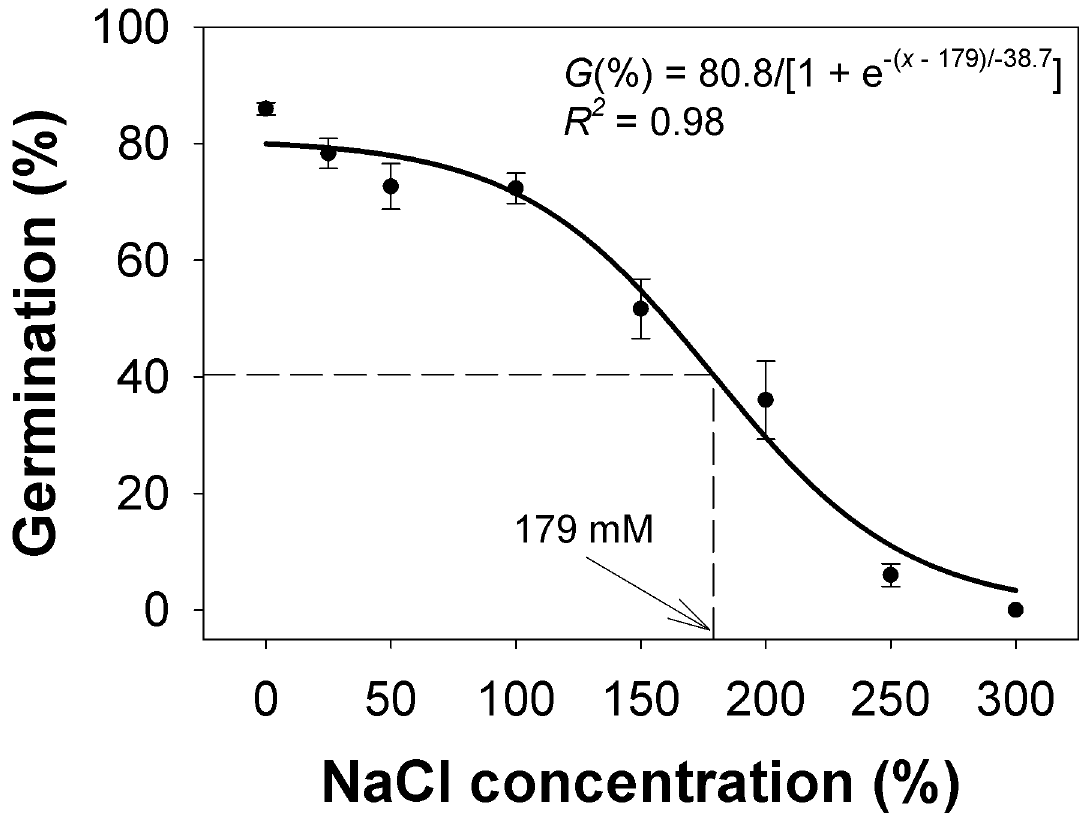
Fig 2. Effect of sodium chloride (NaCl) concentration on seed germination of Chloristruncata after 21 d of incubation at 25/15˚C day/night temperature. The line represents a three-parameter sigmoid model fitted to the data. The arrow shows the NaCl concentration required to inhibit 50% germination. Vertical bars represent standard error of